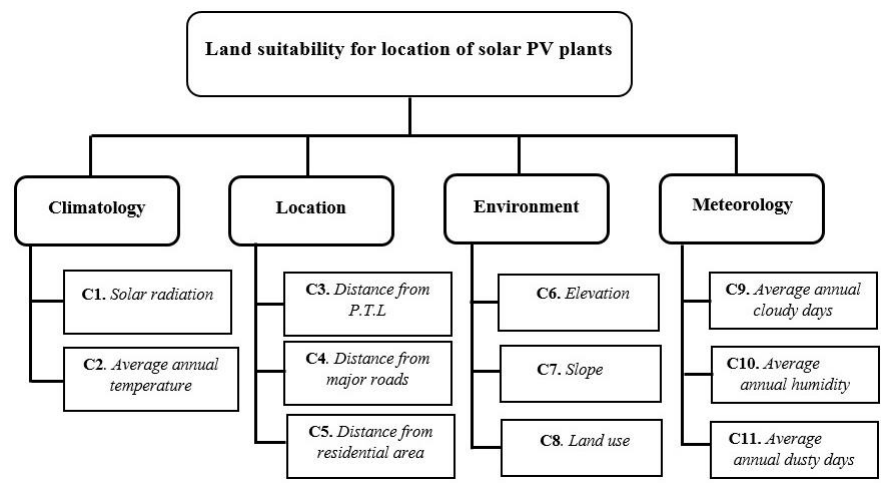
Figure 3. Evaluation criterion for location of solar PV plants.